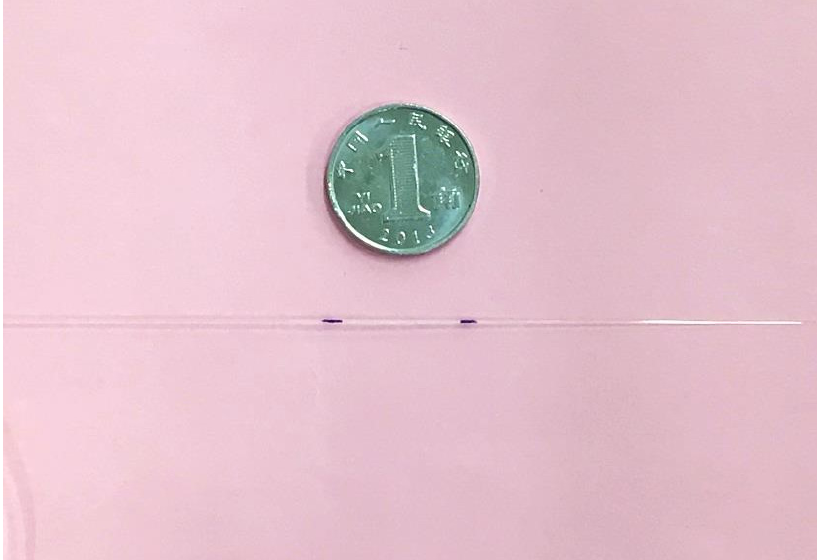
Figure 7. Bare FBG sensor.